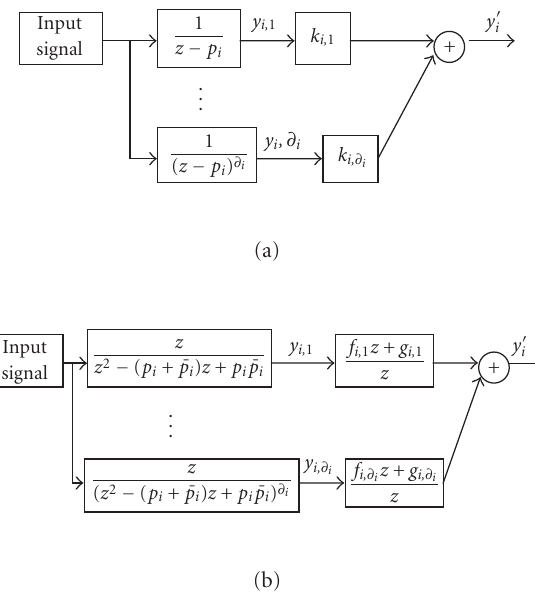
Figure 2.1. (a) Decomposition for a real pole of multiplicity ∂ i . (b) Decomposition for a pair of com- plex conjugate poles with multiplicity ∂ i